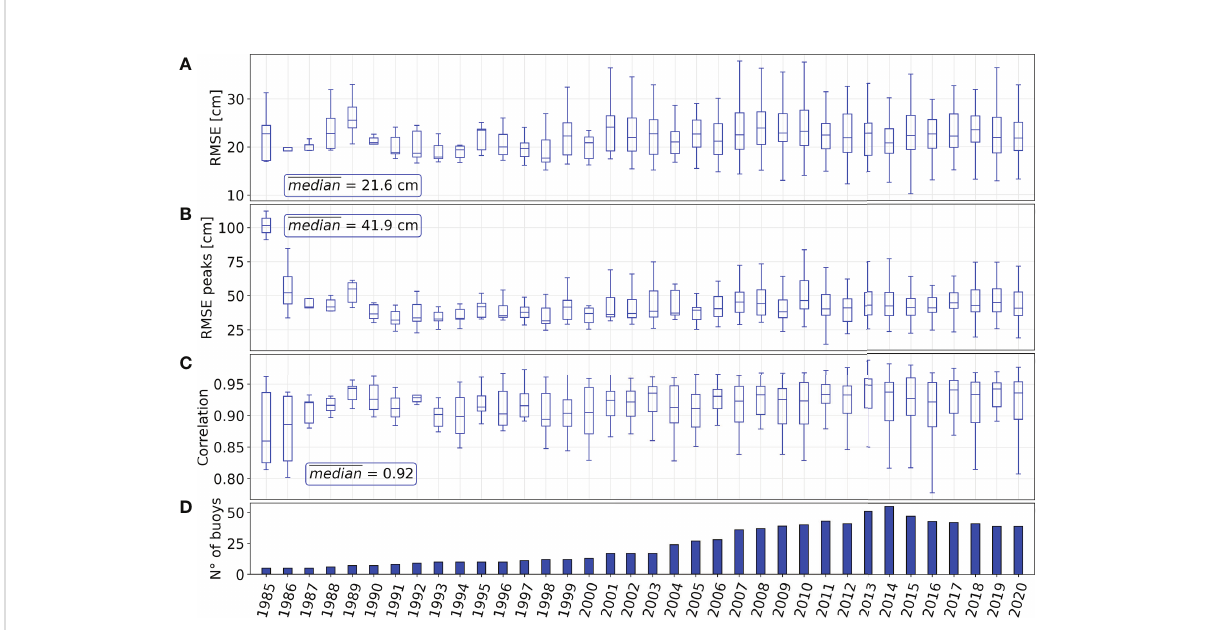
FIGURE 7 Boxplot analysis of differences observed between wave buoys signal and simulated H S , using RMSE, RMSE peaks and Pearson correlation coef fi cient ( fi rst three panels). See Figure 3 for boxplot details. The lowest panel shows the annual number of wave buoy